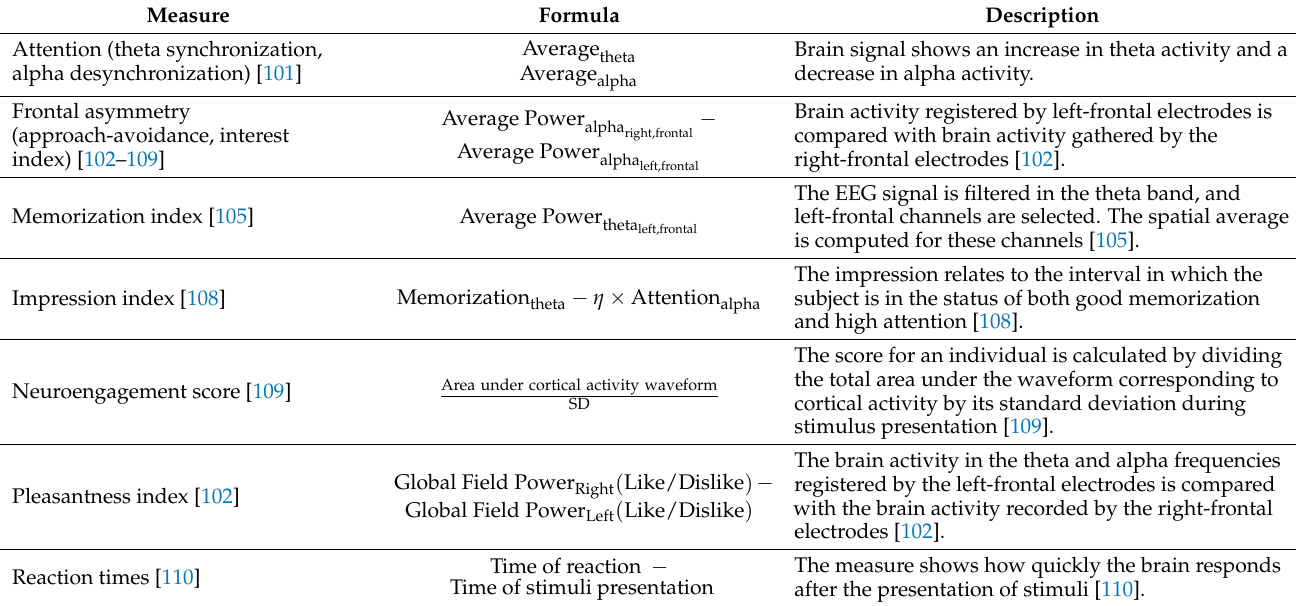
Table 2. Examples of EEG measures (source: own